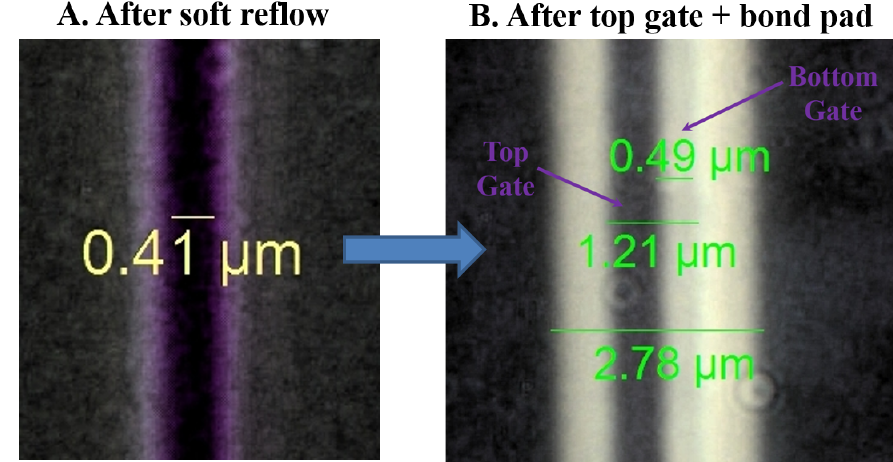
Figure 5. T-gate device fabrication by improved soft reflow chamber setup.